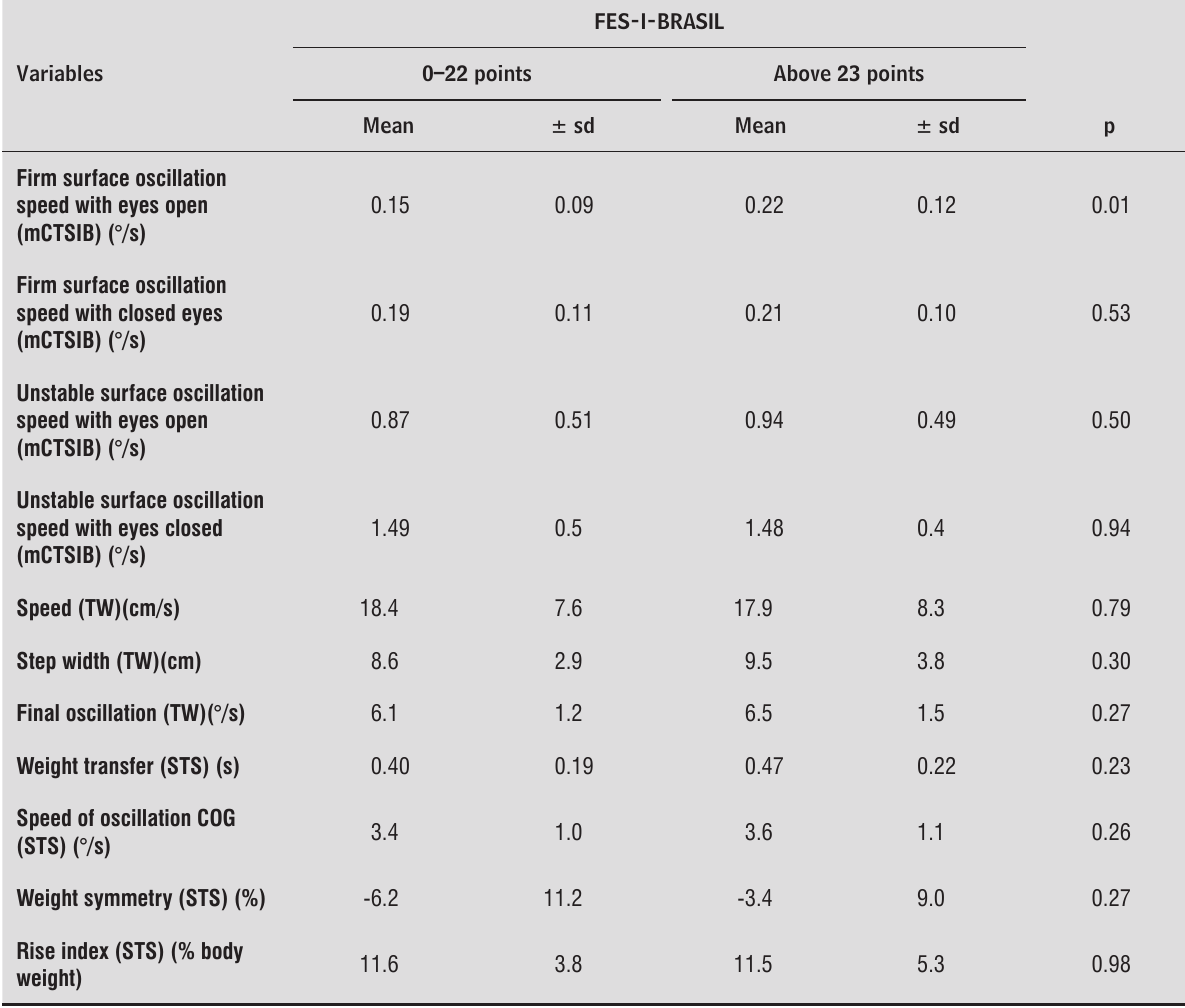
Table 3 - Mean and standard deviation (± sd) of the variables in the balance master system on self-efficacy function in falls in the Community-dwelling elderly women of Natal, RN, 2012